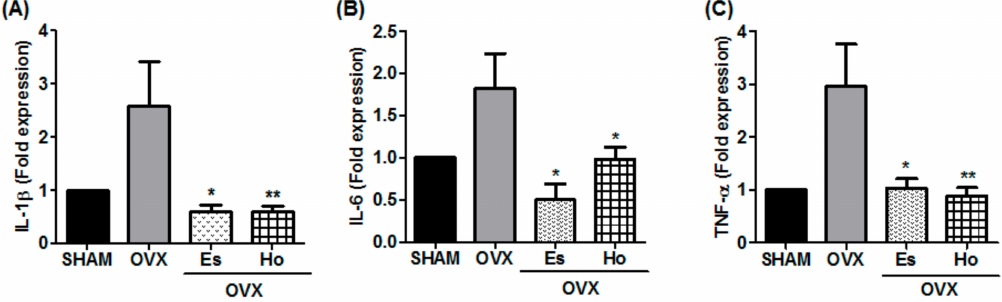
Figure 3. Honokiol inhibited liver inflammatory molecules in OVX mice. mRNA expressions in liver tissues from mice of each treatment groups were assessed using real time PCR analysis. Related expression of ( A ) IL-1 β , ( B ) IL-6 and ( C ) TNF- α were normalized with the β -actin gene. * p < 0.05 and ** p < 0.01 vs. OVX